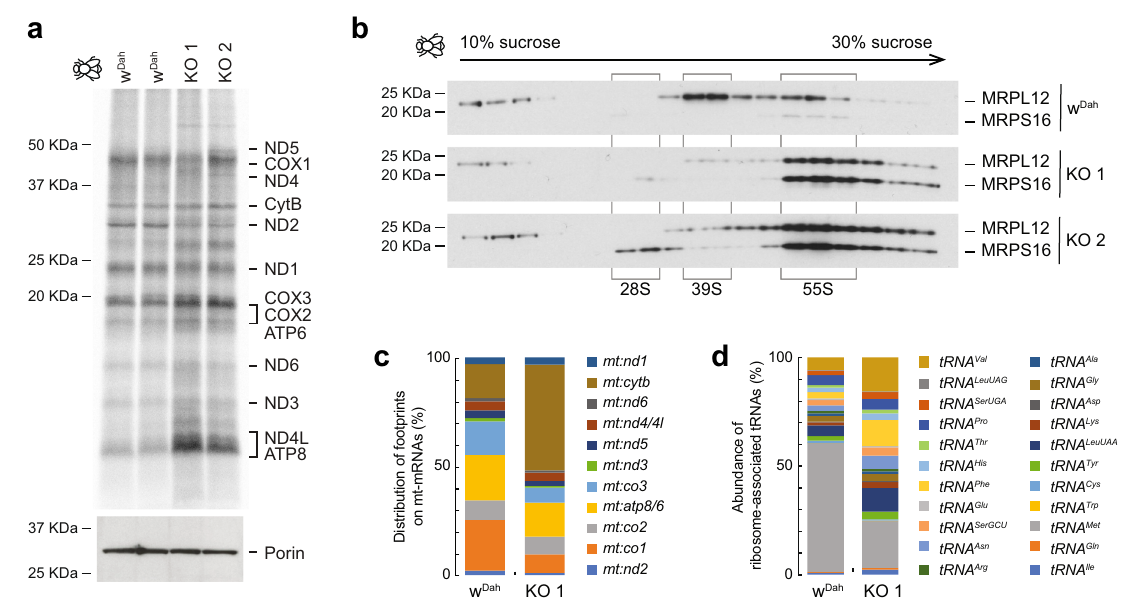
Fig.5|Incompletenon-canonicalprocessingduetolossofDmANGELresultsin aberrant mitochondrial translation. a De novo translation in isolated mito- chondria from 4-dael control (w Dah ) and DmAngel KO (KO 1,2) larvae. Mitochondrial proteins are indicated. Porin was used as loading control. A representative experiment is shown with n =2 biologically independent samples, of two inde- pendent experiments performed. b Western blots of ribosome gradient fractions from 4-dael control and DmAngel KO larvae, decorated with antibodies against the